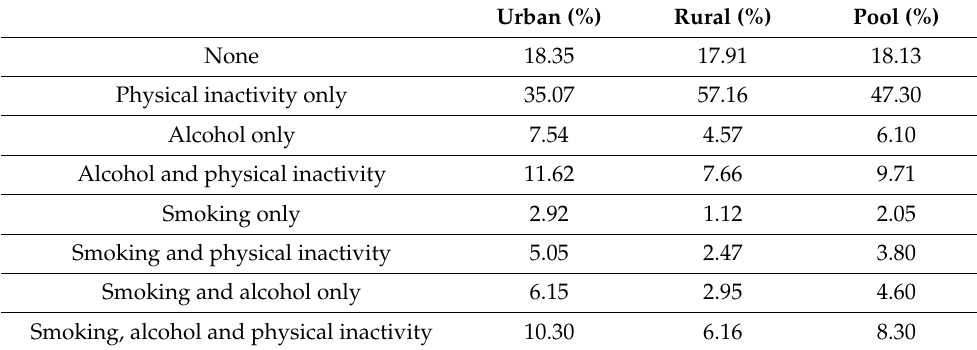
Table 3. Distribution of lifestyle risk factors by geographical